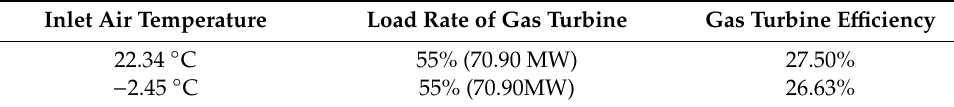
Table 1. Operating data from the gas turbine power plant in